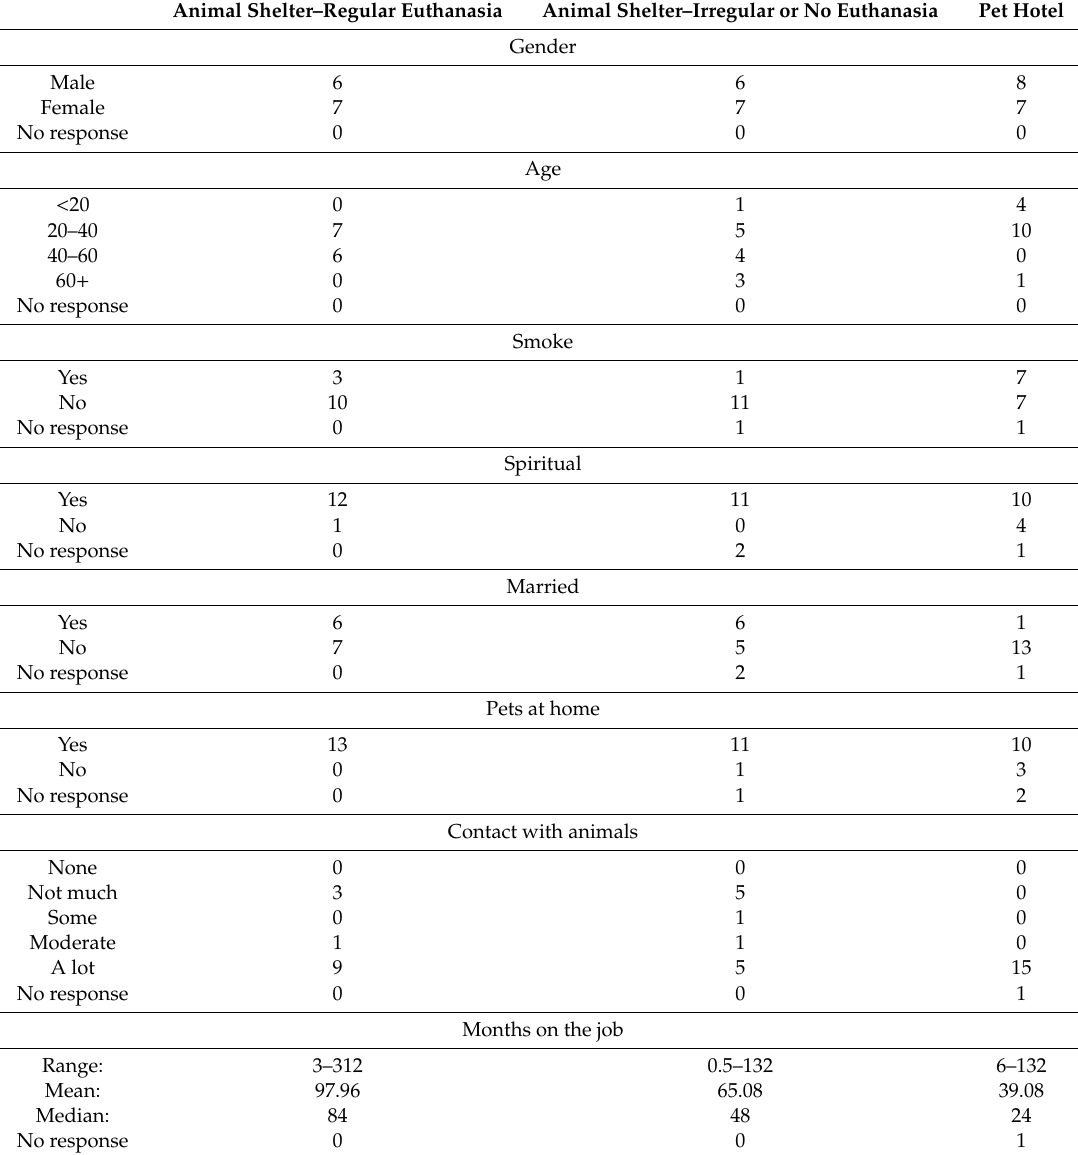
Table 2. The demographic information for Experiment